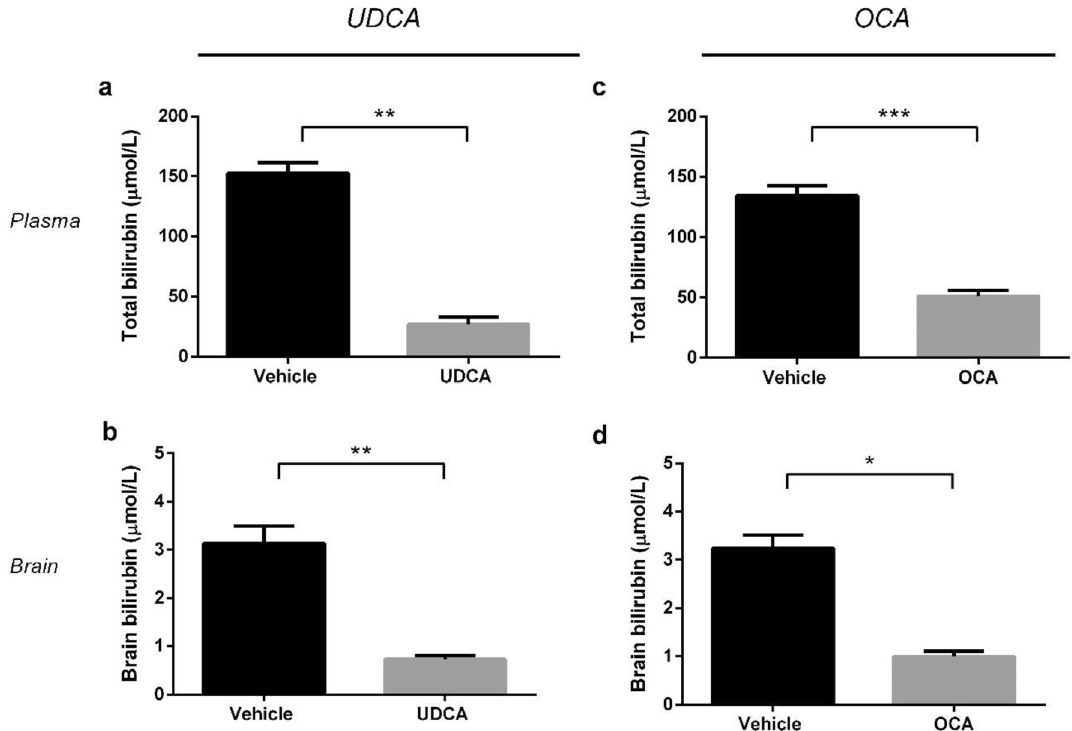
Figure 1. Effect of UDCA and OCA on plasma and brain bilirubin concentrations in neonatal hUGT1*1 mice. Levels of plasma and brain bilirubin in neonatal in hUGT1*1 mice after treatment with ( a , b ) UDCA (250 mg/ kg/day, n = 6) or ( c , d ) OCA (50 mg/kg/day, n = 8). Concentrations of bilirubin in the brain tissue are expressed as µmol/L of tissue